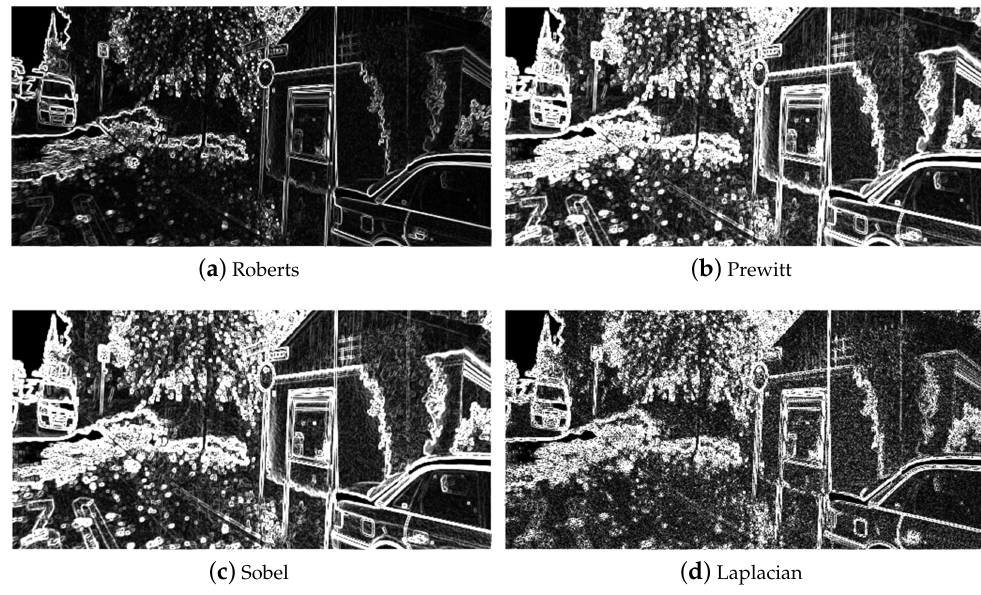
Figure 3. Image edge map with four